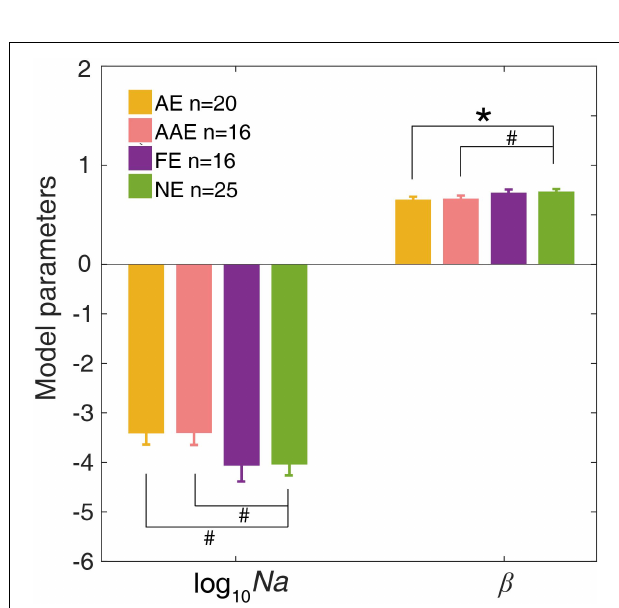
FIGURE 4 | The average Na (in log10 units) and β of the best-fitting ePTM. Yellow: AE. Pink: AAE. Purple: FE. Green: NE. Error bars represent ± 1 standard error. *: p < 0.05. #: 0.05 < p <